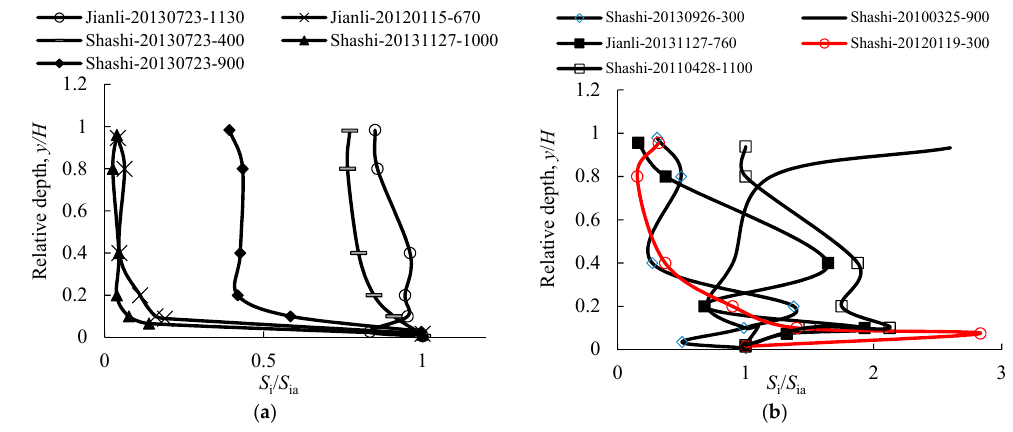
Figure 5. Typical vertical profiles of type I ( a ) and type II ( b ) with tailing phenomena. The legends are composed of station name, date of measurement, and lateral distance of vertical line from left bank. S i = measured concentration of the vertical profile (kg/m 3 ), and S ia = measured concentration of the near-bed point (kg/m 3 ). Water 2017 , 9 , 986